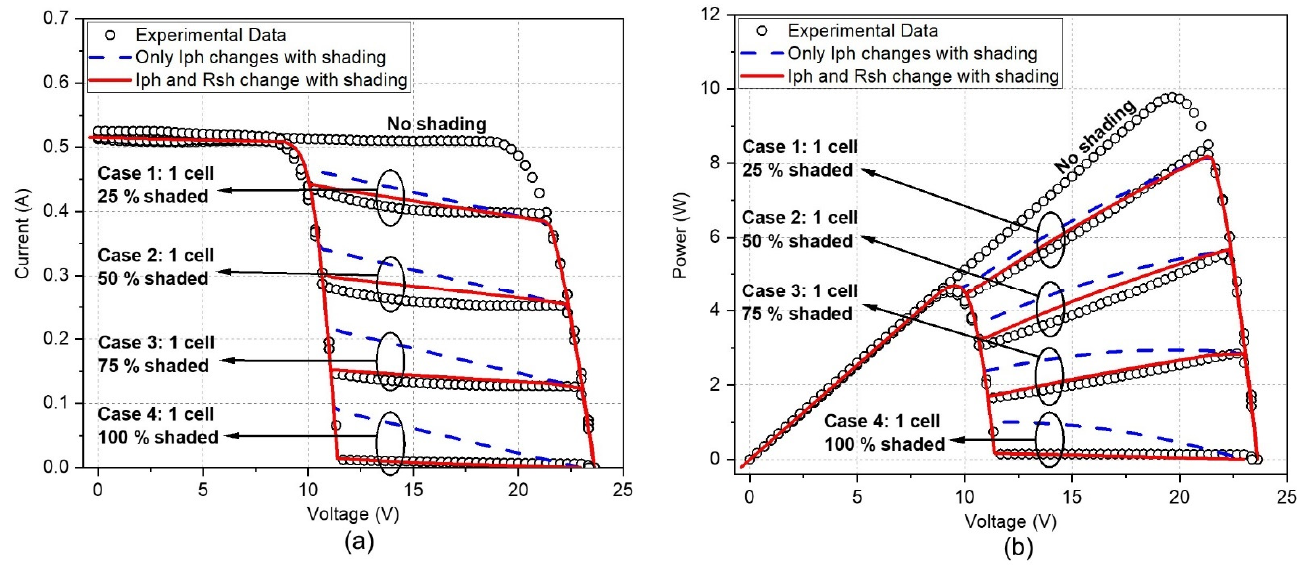
reported in [8,49].